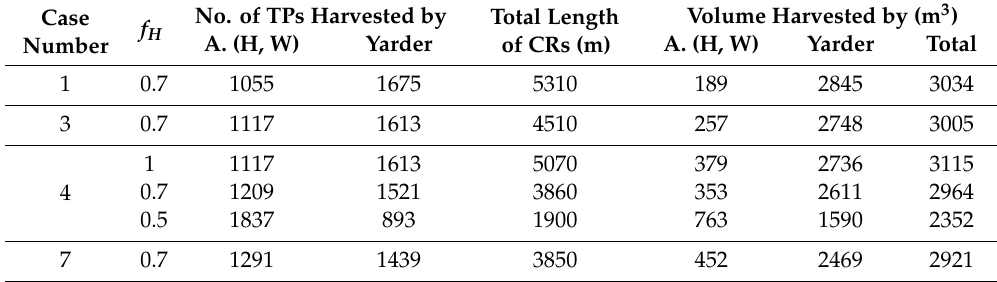
Table 6. CR and harvesting layouts properties of weighting cases 1, 3, 4, and 7. The